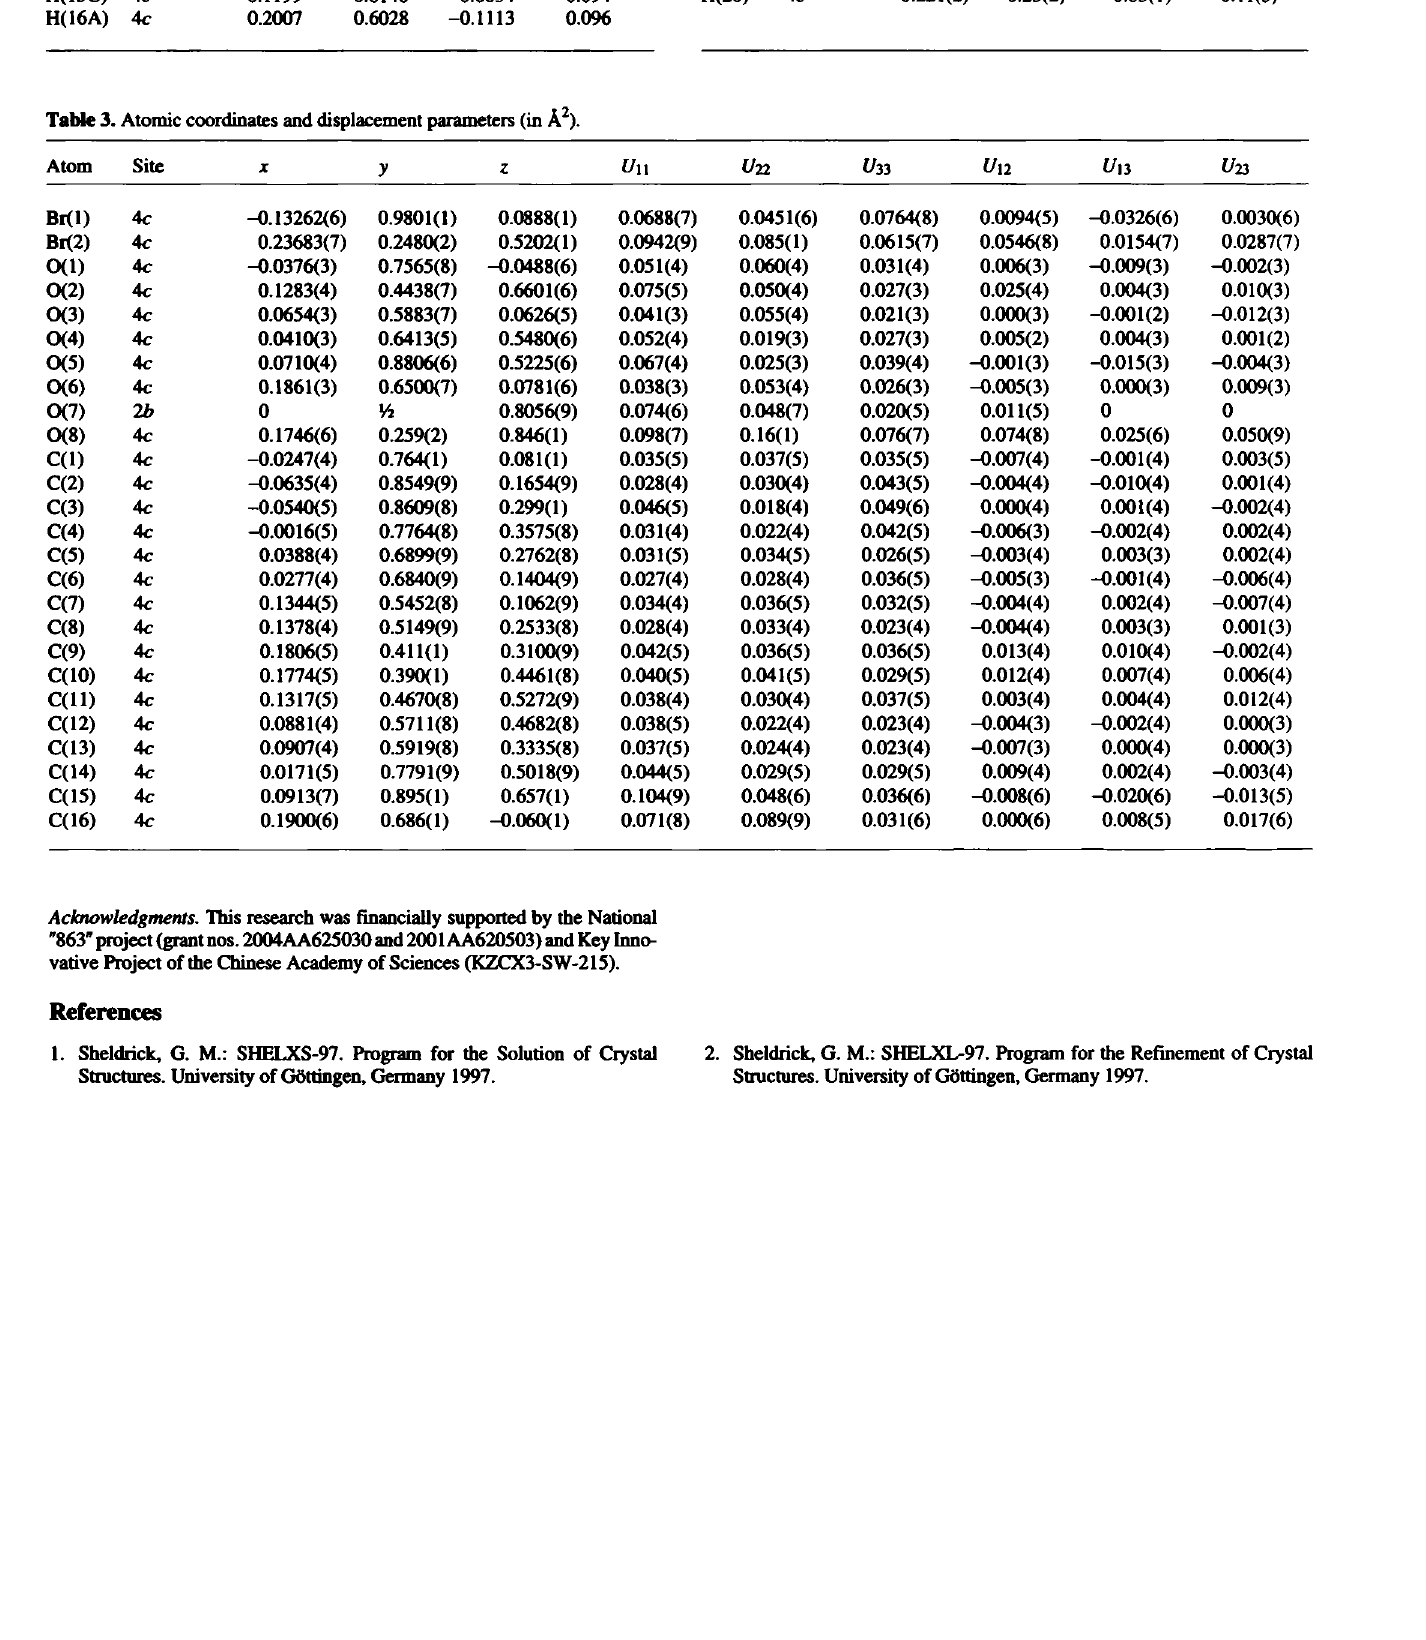
Table 3. Atomic coordinates and displacement parameters (in A 2